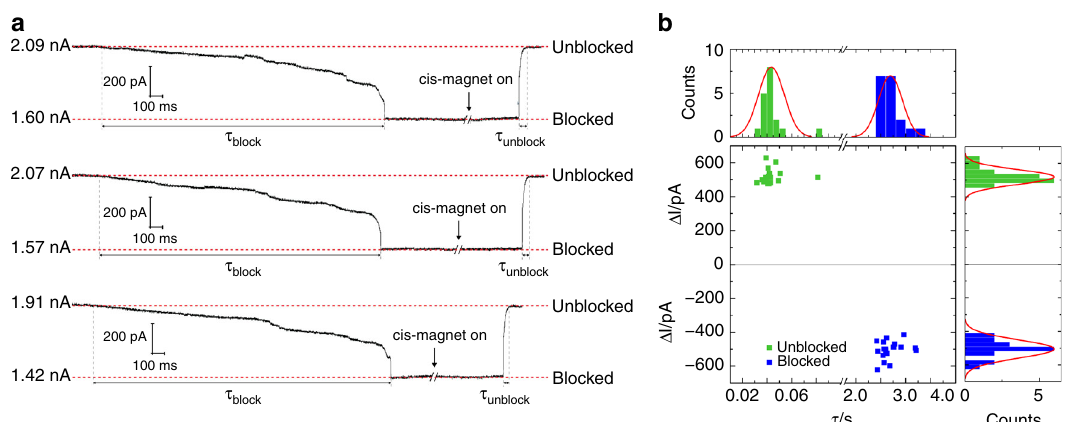
Fig. 2 Controlled blocking and unblocking of nanopore with MNP. a Concatenated ionic current traces showing blocking and unblocking events of a 27 nm solid-state nanopore modi fi ed with silane-EG 6 SAM by 50 nm MNPs. 180-nm-thick SiN membranes were employed here. All traces were recorded in 100 mM KCl and 10 mM Tris pH 7.4 at a potential bias of 100 mV, low-pass- fi ltered at 10 kHz and sampled at 250 kHz. b Nanopore blocking and unblocking event statistics. Each data point in the scatter plot corresponds to the parameters of individual blocking and unblocking events ( n = 18, respectively) measured from ionic current traces. Δ I and τ histograms are fi tted with Gaussian distribution functions (red solid lines) with a bin size of 0.2 nA for Δ I and bin sizes of 0.2 s and 0.005 s for τ block and τ unblock respectively